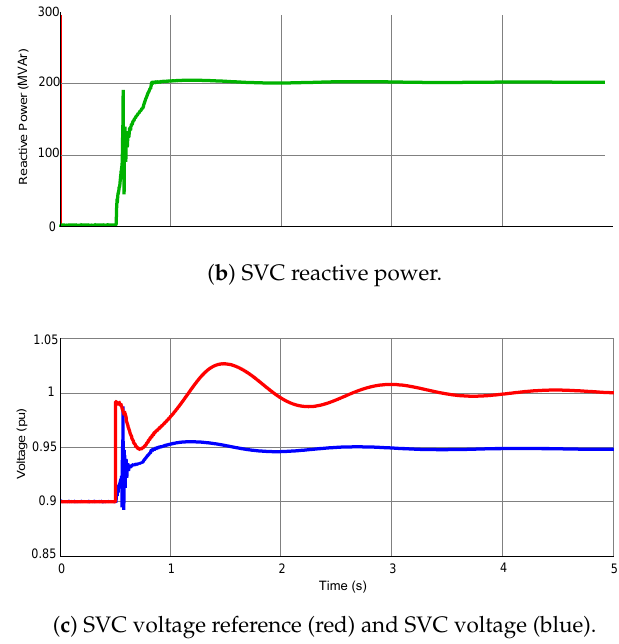
Figure 9. Transient response of SVC voltage reference given by Equation (4).